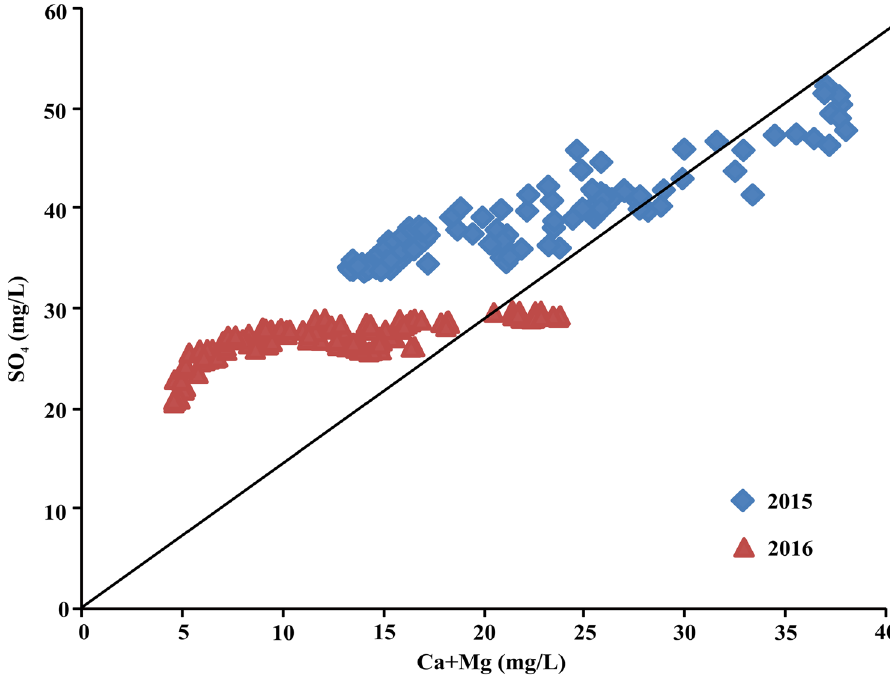
Fig. 8 Scatter plot between (Na + K) and Cl to determine the contribution of ions in the meltwater from atmospheric input and other